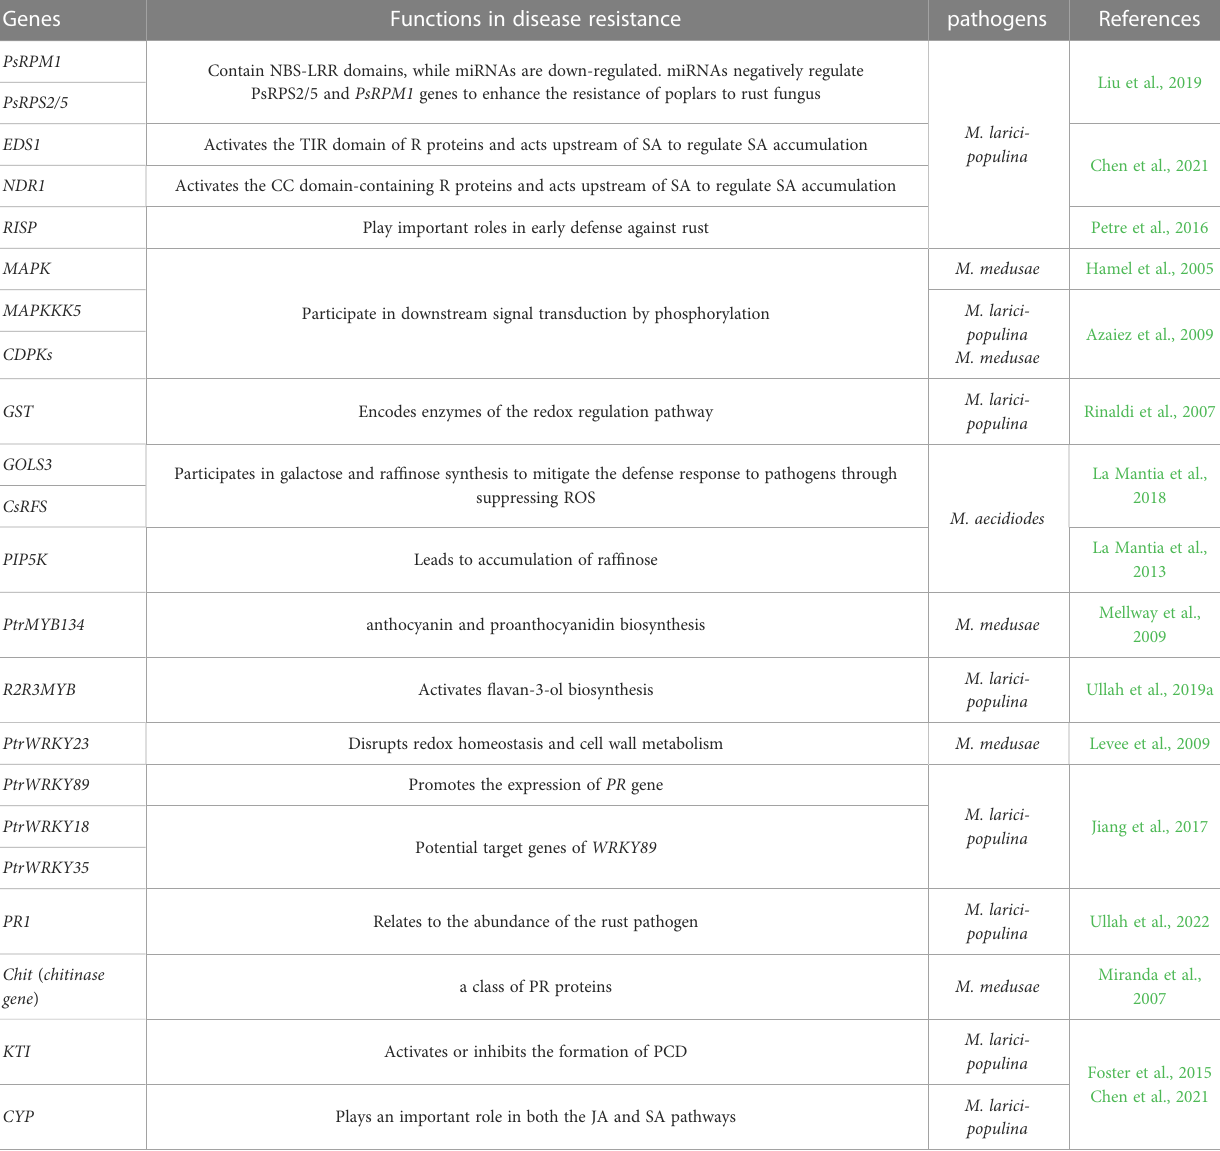
TABLE 1 The genes involved in poplars defense response to biotrophic fungus.